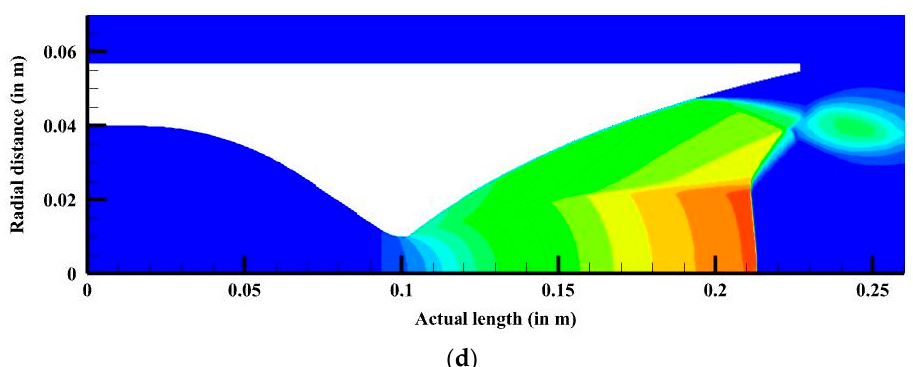
Figure 6. Mach contours for different nozzle pressure ratios: ( a ) NPR 14 ( b ) NPR 22 ( c ) NPR 30 and ( d ) NPR 40.